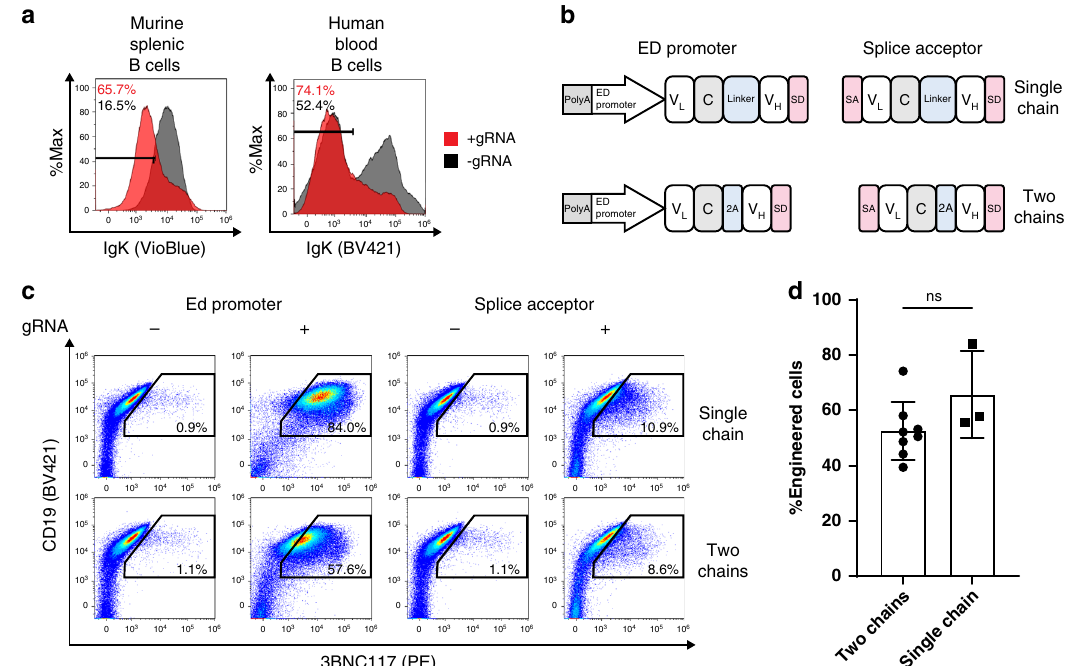
Fig. 2 Engineering B cells with a reduced risk for the mispairing of transgenic and endogenous chains. a Flow cytometry of gRNA-dependent IgK ablation, gating on live, singlets for human cells and live, singlets, CD19 + for mouse cells. b Scheme of 4 alternative rAAV donor vectors where the 3BNC117 bNAb is coded as two chains separated by a furin cleavage site and a sequence coding for a 2A peptide (bottom) or where the bNAb is coded as a single chain using a linker (up) and is preceded by an ED promoter (left) or a splice acceptor sequence (right). c Representative analysis by fl ow cytometry of 3BNC117 expression in primary mouse splenic lymphocytes monitored two days following transduction and detected by anti-idiotypic antibody. Gating on live, singlets. d Quanti fi cation of c for ED promoter driven cassettes, two-tailed t -test ( n = 7 for the two chain and n = 3 for the single chain construct, each dot represents a biologically independent sample, data represented as mean values + / −